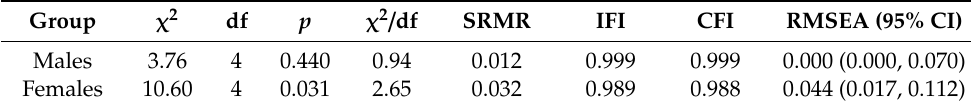
Table 3. Fit indexes of model across gender.